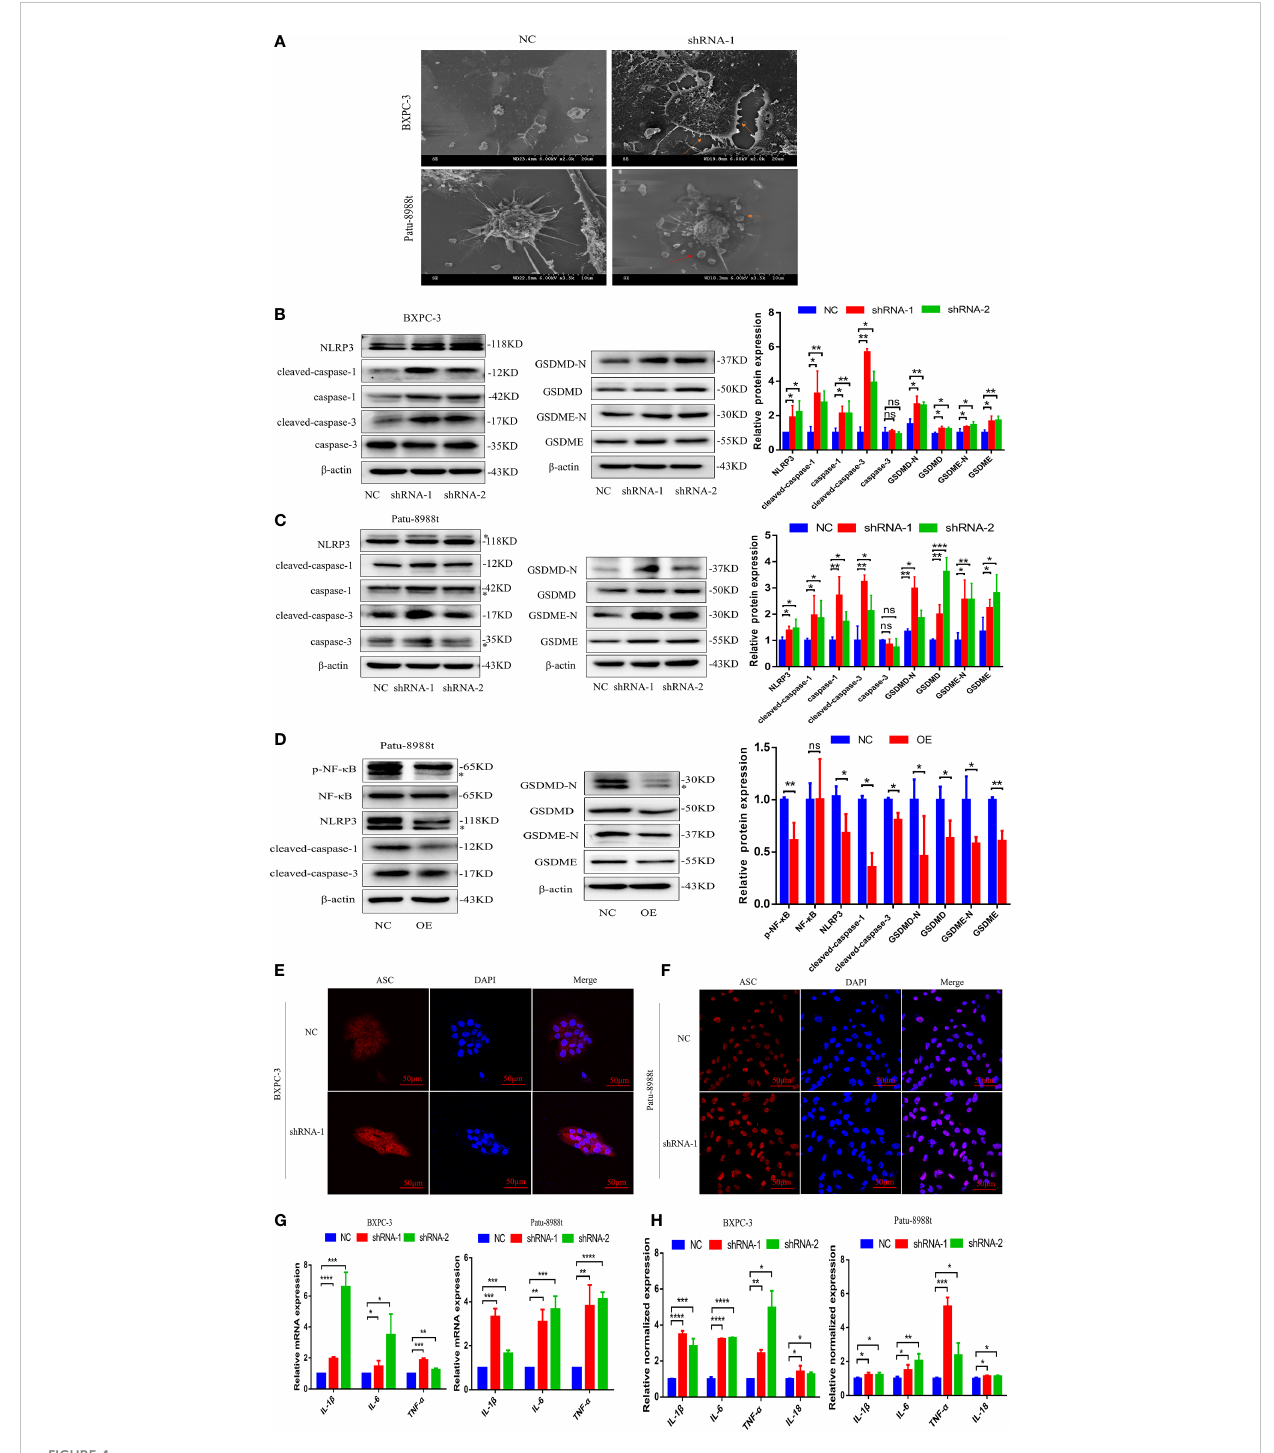
FIGURE 4 GALNT6 promotes the release of in fl ammatory factors and pyroptosis in PDAC cells. (A) Pyroptosis of BXPC-3 and Patu-8988t cells after knockdown of GALNT6 detected by SEM. Red arrows point to pyrosomes formed in cells and ruptured cell membranes. (B, C) Western blot assay was used to detect the changes of NLRP3, cleaved-caspase-1, caspase-1, cleaved-caspase-3, caspase-3, GSDMD-N, GSDMD, GSDME-N and GSDME expressions in BXPC-3 and Patu-8988t cells after knockdown of GALNT6. The asterisk indicates a heterozygous band. (D) The expression levels of p-NF- k B, NF- k B, NLRP3, cleaved-caspase-1, cleaved-caspase-3, GSDMD, GSDMD-N, GSDME and GSDME-N in overexpression GALNT6 Patu-8988t cells were measured by western blot assay. The asterisk indicates a heterozygous band. (E, F) ACS in BXPC-3 and Patu-8988t cells was analyzed by immuno fl uorescence. (G) The mRNA expression of IL-1 b , IL-6 and TNF- a in BXPC-3 and Patu-8988t cells were detected by qRT-PCR. (H) ELISA was used to detect the levels of IL-1 b , IL-6, TNF- a and IL-18 in BXPC-3 and Patu-8988t cells. Each experiment was repeated at least three times independently, and the experimental data were expressed as mean standard deviation (X ± SD). ns, p >0.05; *p <0.05; **p <0.01; ***p <0.001; ****p